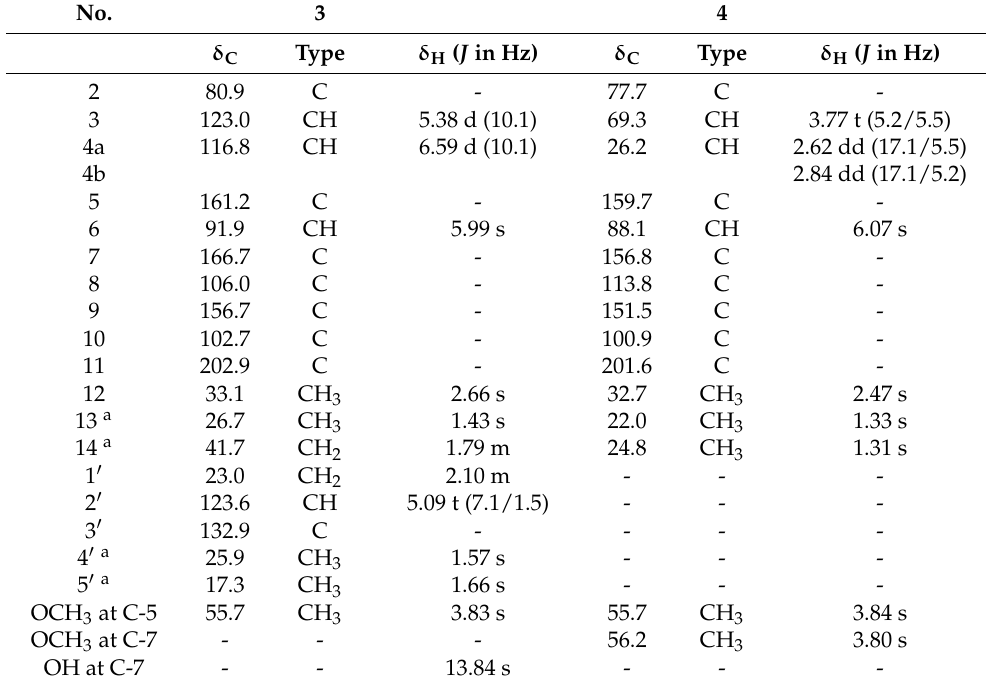
Figure 2. Key correlations of 1 and 2 in the HMBC spectrum. Table 2. 1 H-and 13 C-NMR data of 3 and 4 (600 and 150 MHz, δ in ppm, in CDCl 3 ). No.